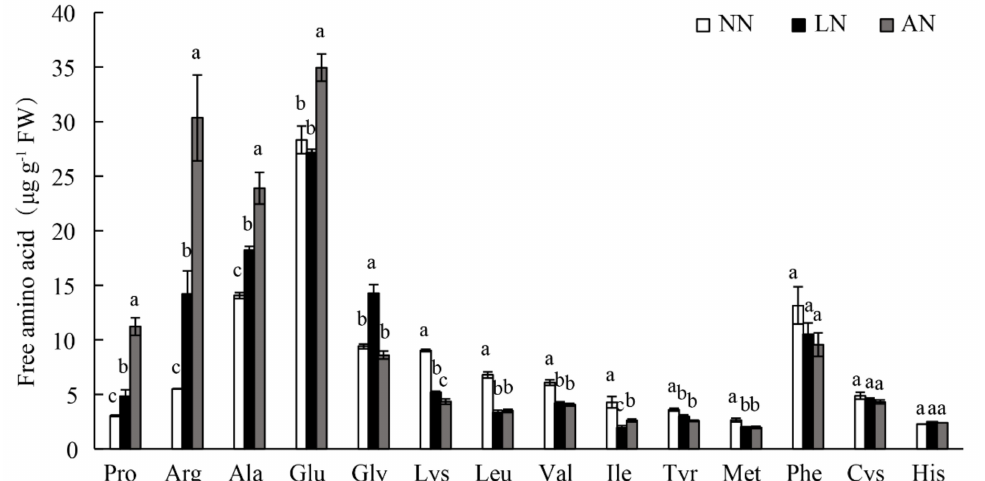
Figure 5. Free amino acids as affected by rhizobia inoculation in Chinese milk vetch. Free amino acids from leaves in plants with active nodules (AN), low-activity nodules (LN), and no nodules (NN) under unstressed control conditions were measured. The presented data are means and standard errors ( n = 3). The same letter above the column indicates no significant difference at p < 0.05.